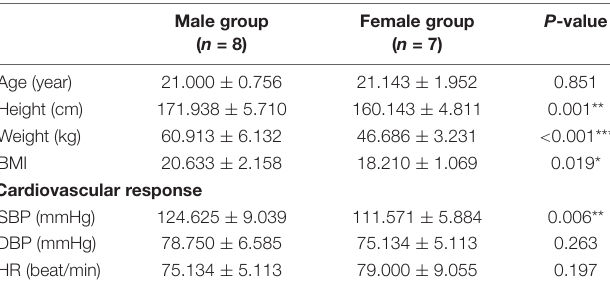
indicated that the total sample size should be 12 based on a level of significance of 0.05 and statistical power of